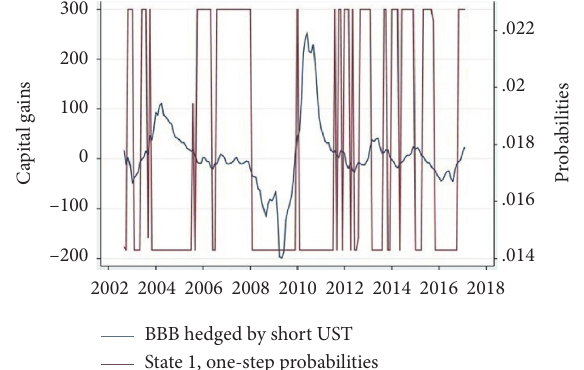
Figure 7: Regime change in means and standard deviations: state plot for the capital gains of the UST-hedged US BBB portfolio,